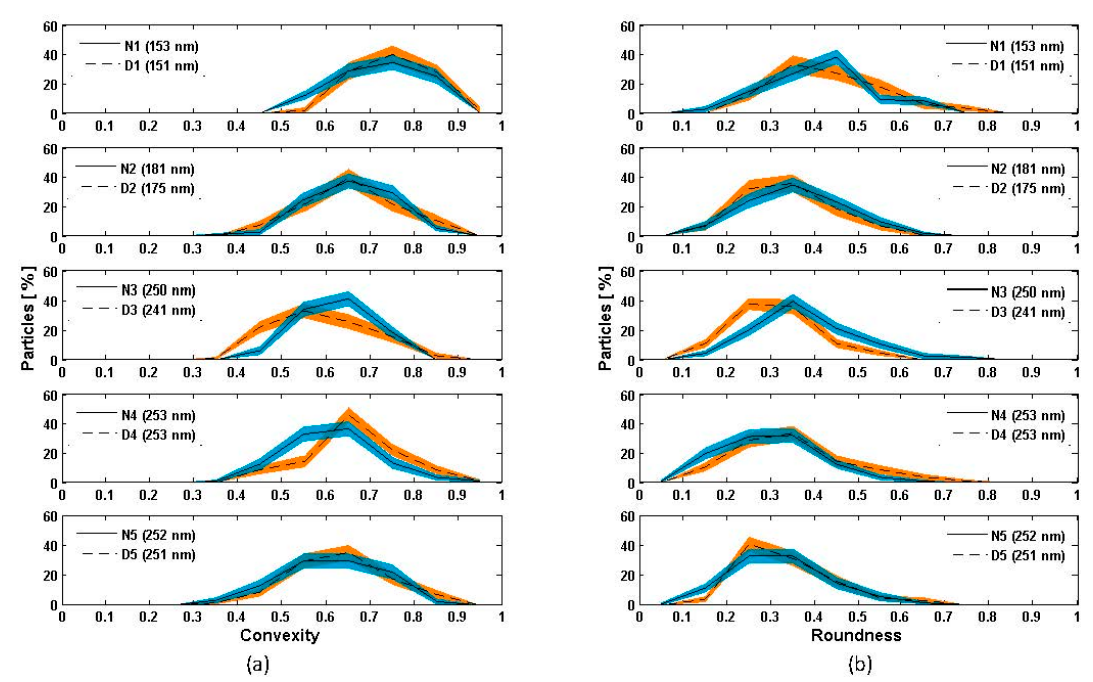
Figure 6. Distributions of ( a ) convexity and ( b ) roundness for nascent and nascent-denuded soot particles of different sizes (the mobility diameter is reported in parenthesis in the legends).